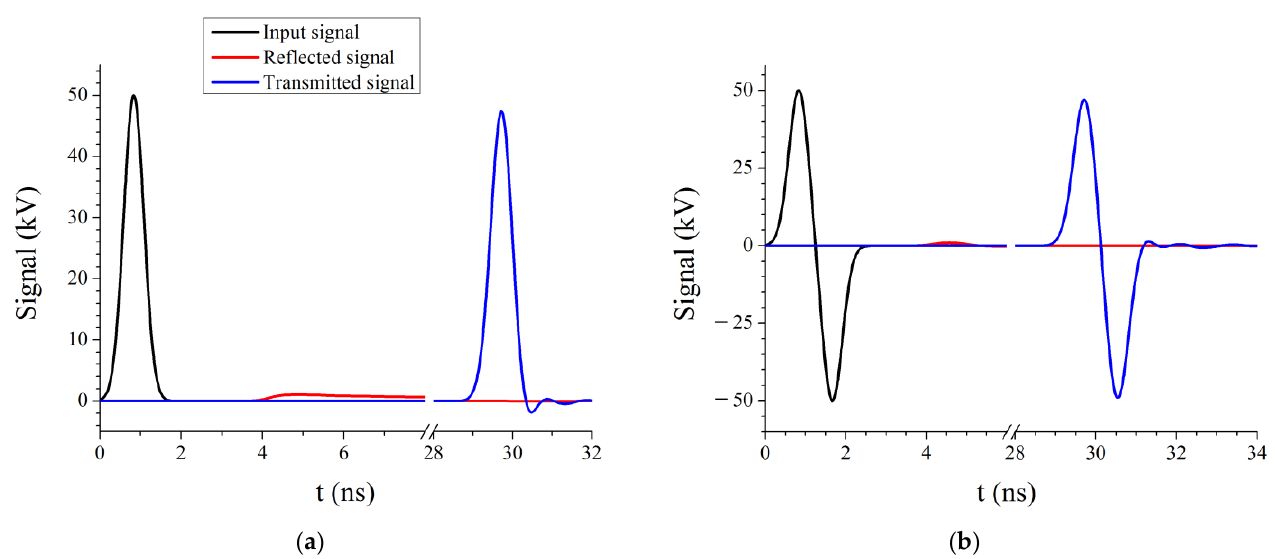
Figure 2. Input, reflected, and transmitted signals with EMP generators connected to the coaxial line, which were found by the numerical simulation: ( a ) unipolar pulse with duration of 600 ps FWHM and an amplitude of 50 kV, and ( b ) bipolar pulse with a duration of 1.4 ns FWHM and the same amplitude.